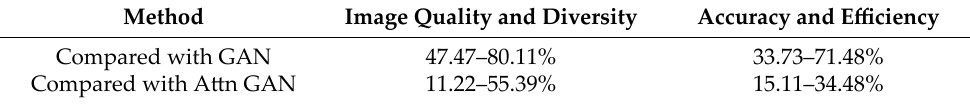
Table 3. Accuracy and efficiency improvement compared with other network models.